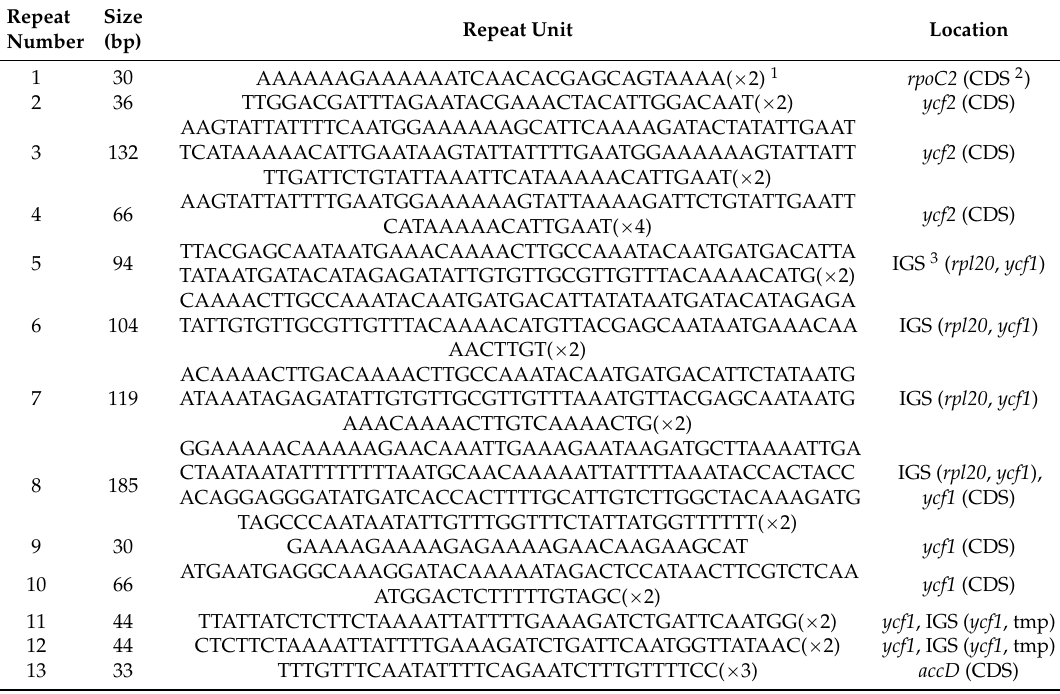
Table 1. REPuter [35] was used to locate and count both forward and inverted repeats in the C. lanceolata chloroplast genome. The minimal repeat size was set to 30 bp and the identity of repeats was set to ě 90%. Fifty-one repeats were detected in the Cunninghamia lanceolata chloroplast genome. Most of them are between 10 and 29 bp in length. Repeats longer than 30 bp are listed in the